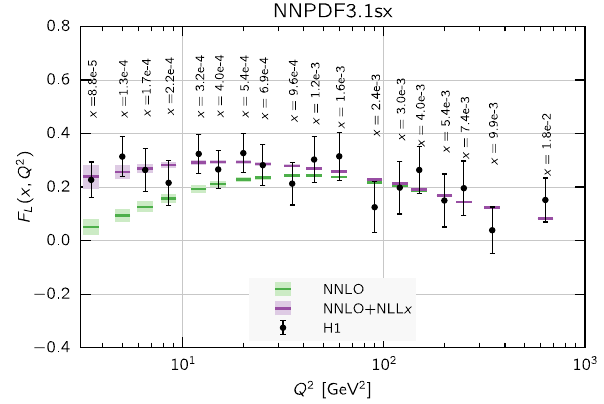
Fig. 21 The longitudinal structure function F L ( x , Q 2 ) as a function of Q 2 for different x bins for the most recent H1 measurement [188], comparing the results of the NNLO and NNLO+NLL x fits